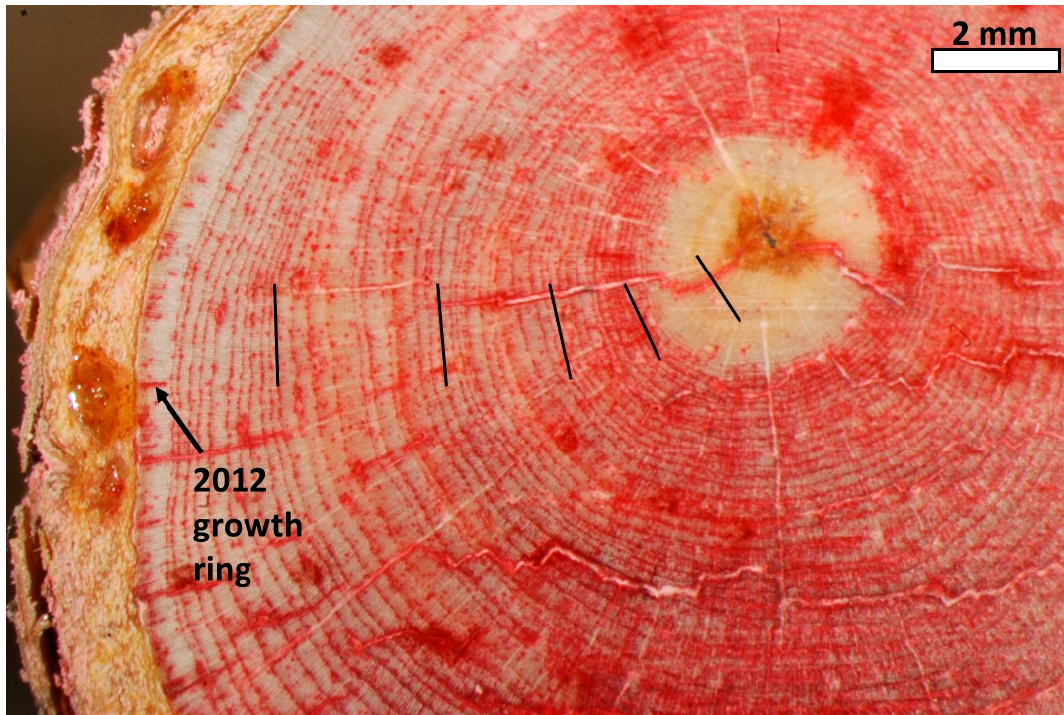
Figure 8. Cross-section of a whitebark pine seedling, with an estimated age of 55 years. Black lines represent 10-year intervals from the outer ring. The 2012 growth ring represents the release response following bark beetle-caused mortality of the understory.